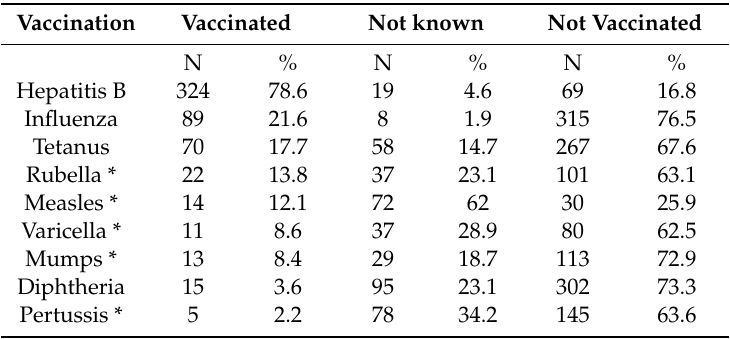
Table 3. Healthcare workers’ self-reported vaccination coverage. Vaccination